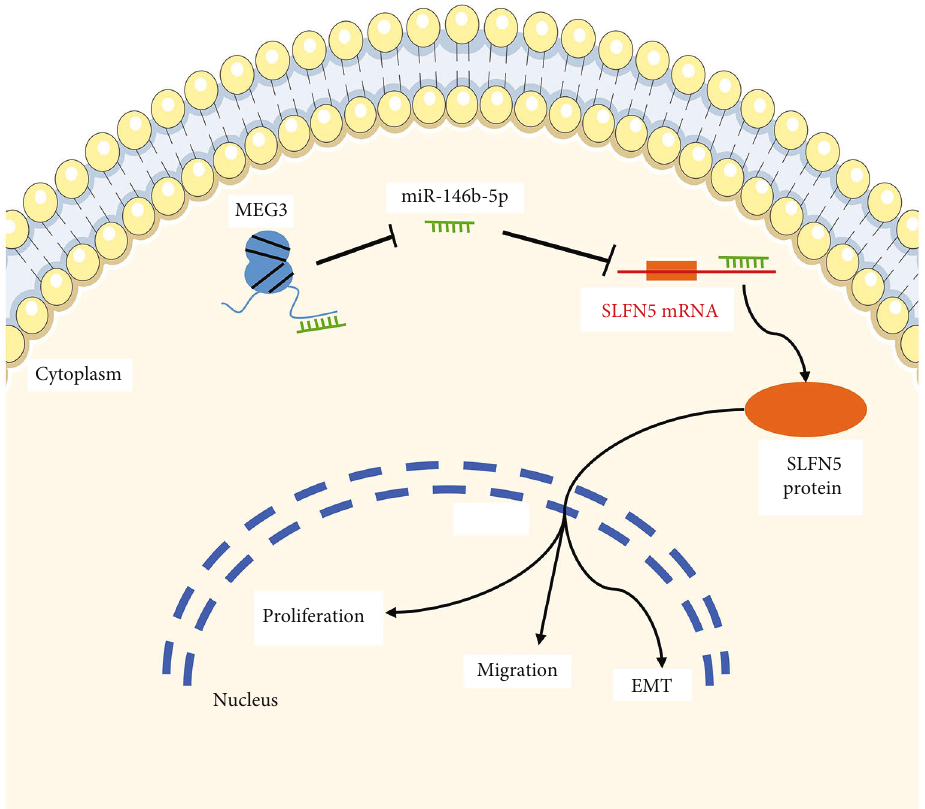
Figure 5: Schematic of MEG3, SLFN5, miR-146b-5p, and the EMT regulatory network in breast cancer